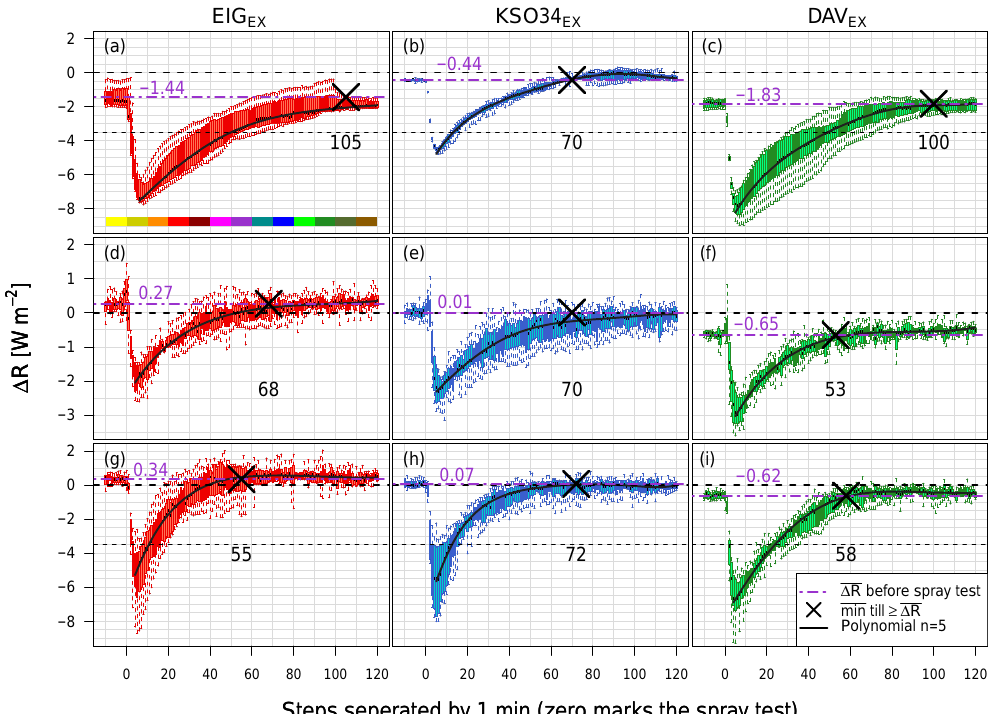
Figure 5. Box–whisker plots (in one minute time intervals) of the difference in radiation measurements ( (cid:49)R ) between individual experi- mental pyranometer/HV-system combinations (EIG EX in red, KSO34 EX , in blue and DAV EX in green) and the reference pyranometer (REF) following the spray tests. Panels (a) – (c) show the results from the experiments during the laboratory campaign, panels (d) – (f) show the results from the first field campaign (January 2016), and panels (g) – (i) show the results from the second field campaign (April–May 2016). The x axis in all panels shows the experiment time, starting 10min before and ending 120min after the spray tests (marked with zero). The purple dot–dashed horizontal line marks the average difference (cid:49)R before the spray test. The black cross marks the average time in minutes which each pyranometer/HV-system pair needed to return to or exceed its initial state (numbers give corresponding time in minutes). The color bar in panel (a) represents the temporal evolution of experiments further analyzed in Fig. 7. In all panels, a polynomial of 5th degree (black solid line) of the median values, beginning at the minimum (maximum pyranometer response), is shown. Note that the scales of the y axes in (d) – (f) differ from those in (a) – (c) and (g) – (i)